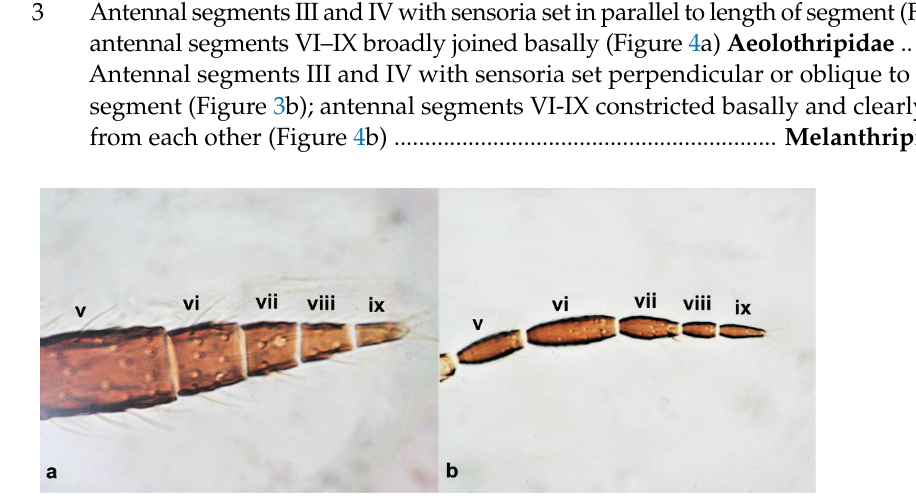
Figure 4. Antennal segments VI–IX: ( a ) broadly joined basally; ( b ) distinct from each other. 4 Antennal segment III about 15 times as long as wide (Figure 5a); antennal segments III and IV with sensoria consisting of a multitude of dot-like structures lined up parallel to length of segment (Figure 5b); fore wings with dark band sub-apically (Figure 5c); abdominal segments I–III significantly narrower than other segments, giving the appearance of a wasp-like waist (Figure 5e) ......... Franklinothrips megalops Trybom Antennal segments III 3.3–5 times as long as wide; antennal segments III and IV with sensoria consisting of one or a small number of continuous ridge shapes lined up par- allel to length of segment (Figure 5b); fore wings with light coloured sub-apical region (Figure 5d); abdominal segments I–III only slightly narrower than other segments (Figure 5f) .............................................................................................................................. 5